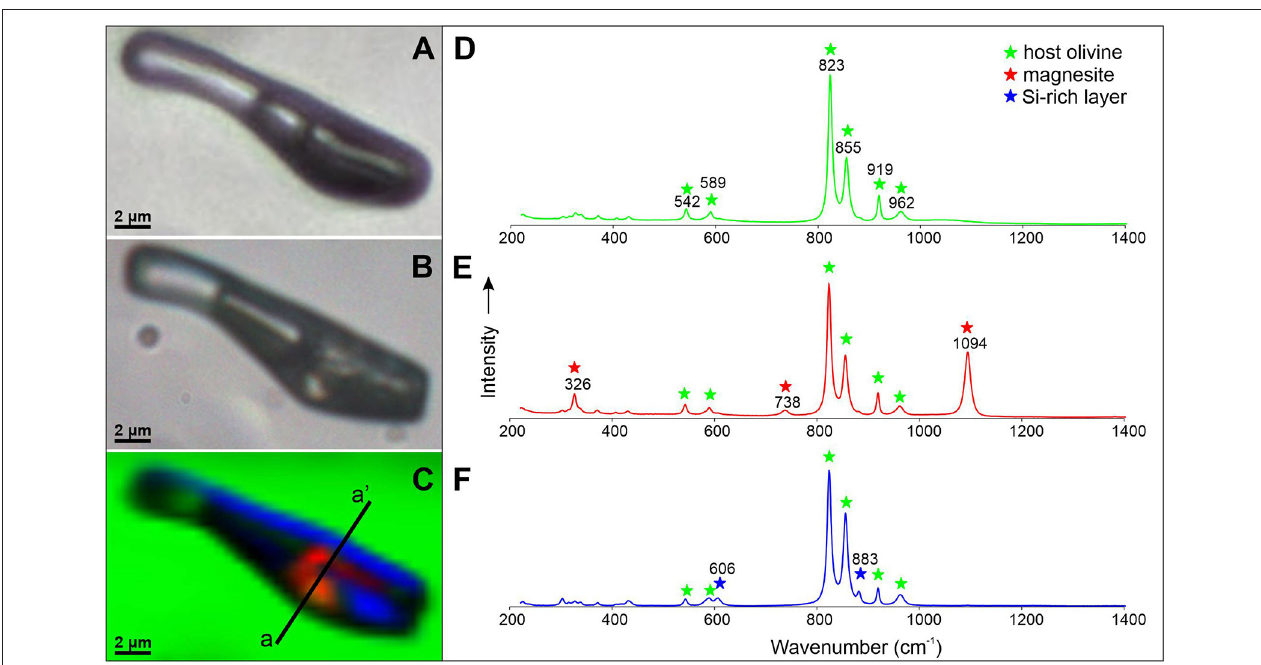
FIGURE 5 | Photomicrographs of a fluid inclusion from sample 11-4-16_IVa taken before the reaction began (A) and after the carbonation reaction (B) , and a Raman map of the reacted, unexposed fluid inclusion (C) . Colors represent the different phases detected and correspond to the Raman spectra shown in (D) (host olivine, green), (E) (magnesite, red), and (F) (Si-rich layer, blue). The cross-section a-a’ shown on (C) shows the location where the FIB-SEM analysis presented in Figure 6 was collected. No CO 2 peaks were observed in the reacted fluid inclusion during Raman mapping, indicating that all (or most) of the initial CO 2 was consumed during the carbonation